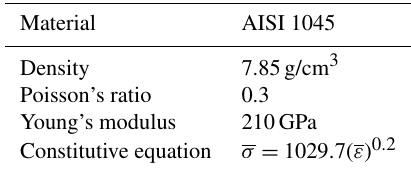
Table 1. Mechanical properties of the workpiece